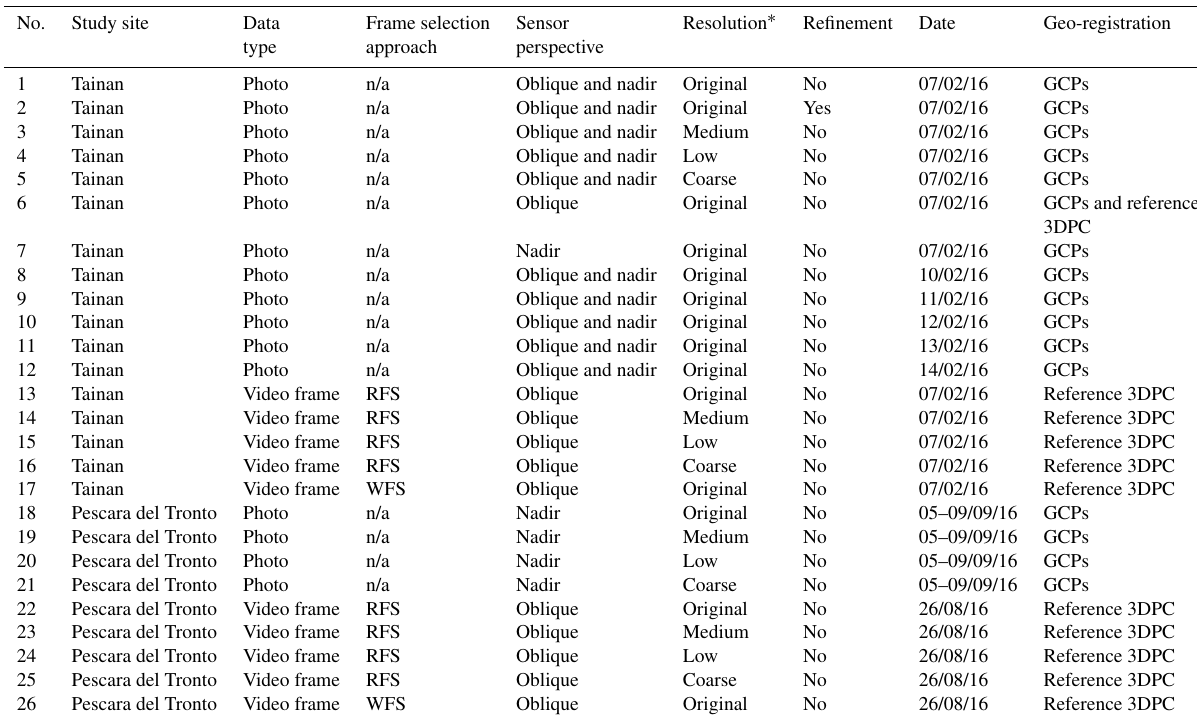
Table 2. Prepared datasets from video and photo data. No. Study site